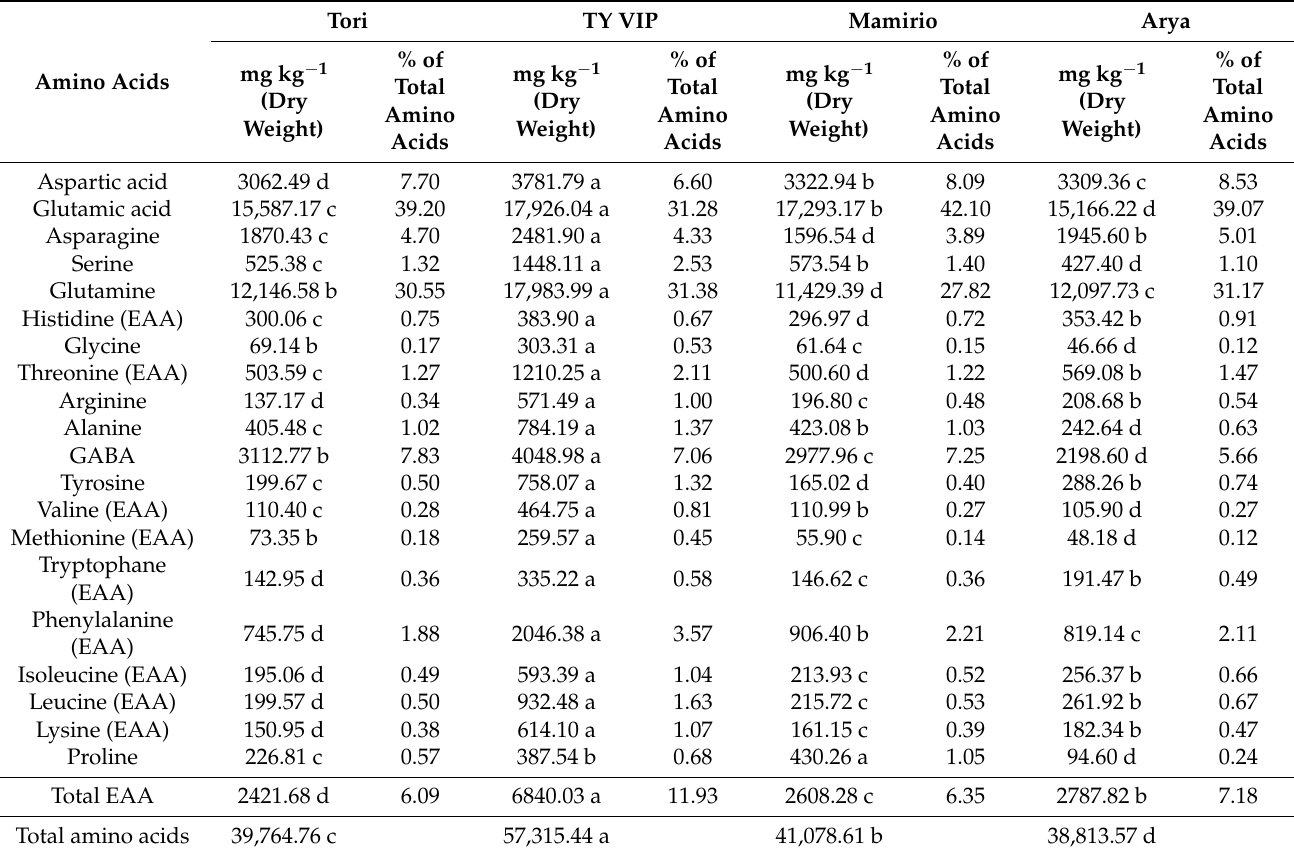
Table 2. Free amino acid content of ‘Tori’, ‘TY VIP’, ‘Mamirio’, and ‘Arya’ tomato cultivars at commercial pink ripening